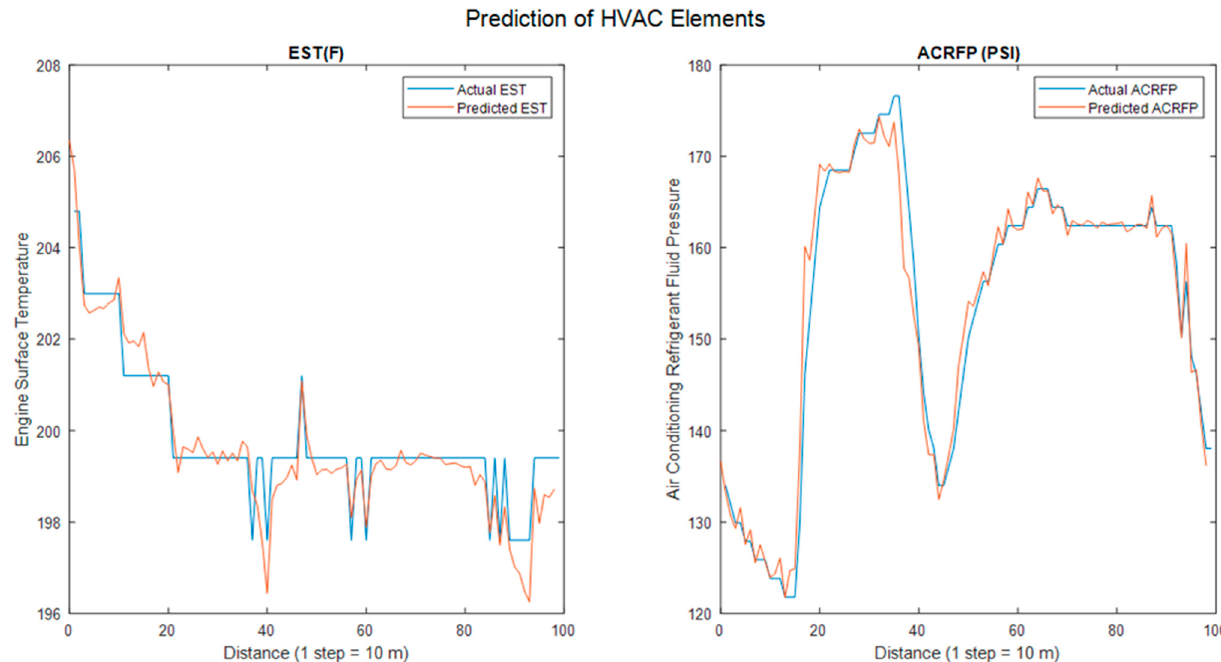
Vehicles 2021 , 3 , FOR PEER REVIEW 10 Figure 6. Prediction of CATOP—ACCSSP = 70 MPH; CAT = 68 °F; EAT = 78.75 °F. Figure 6. Prediction of CATOP—ACCSSP = 70 MPH; CAT = 68 ◦ F; EAT = 78.75 ◦ F.